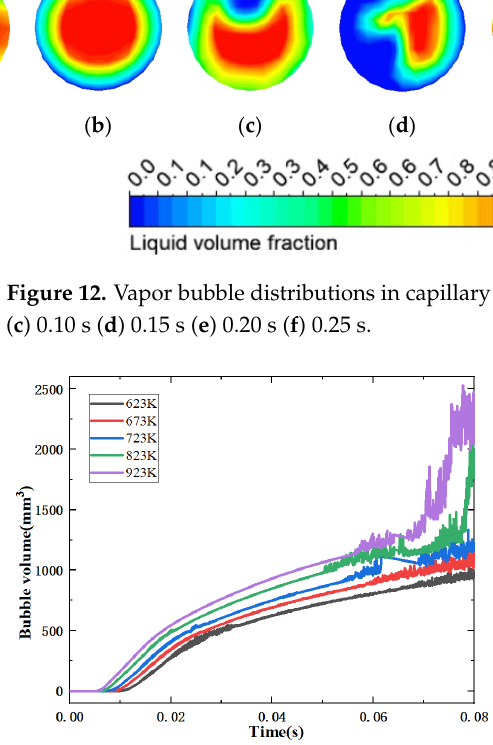
Figure 13. Variation of bubble volume in capillaries at different temperatures.